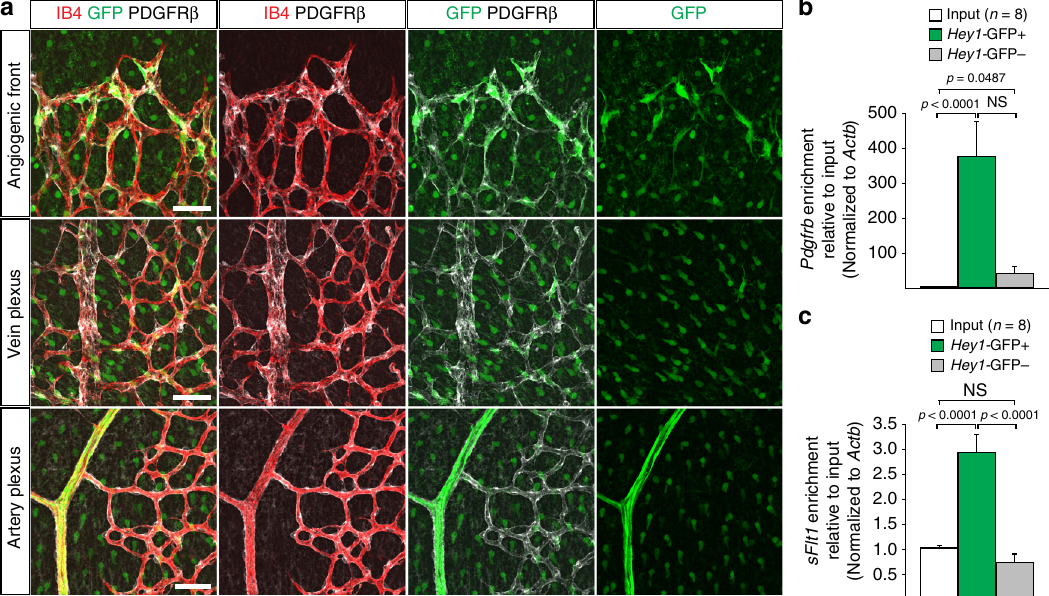
Fig. 6 Expression of sFlt1 in pericytes at the angiogenic front. a Maximum intensity projections of confocal images from P6 retinas of the Hey1 -GFP transgenic reporter mouse model stained for GFP (green), PDGFR β + (white) and IB4 (red). Images of the fi rst row show enrichment of Hey1 -GFP+, PDGFR β + perivascular cells in the angiogenic front in comparison to mural cells covering the remodeling central plexus around veins (middle row) and arteries (bottom row). Note strong expression of Hey1 -GFP reporter in arterial ECs (bottom row). Scale bar , 50 µ m. b , Quantitation of Pdgfrb expression by qPCR in P6 PDGFR β + retinal pericytes sorted based on GFP expression in comparison to whole-retina single-cell suspension (input). Note signi fi cant enrichment of Pdgfrb in both (GFP+ and GFP − ) pericyte fractions and higher expression in the Hey1 -GFP+ subset. Error bars, s.e.m. p -values, Kruskal – Wallis and Dunn ’ s multiple comparison test. NS, not statistically signi fi cant. c Quantitation of sFlt1 expression by qPCR in sorted P6 retinal pericytes in comparison to whole- retina single-cell suspension (input). Note signi fi cant enrichment of sFlt1 expression in Hey1 -GFP+ pericytes in comparison to input and GFP- pericytes. Error bars, s.e.m. p -values, one-way ANOVA and Tukey ’ s multiple comparison test. NS, not statistically signi fi